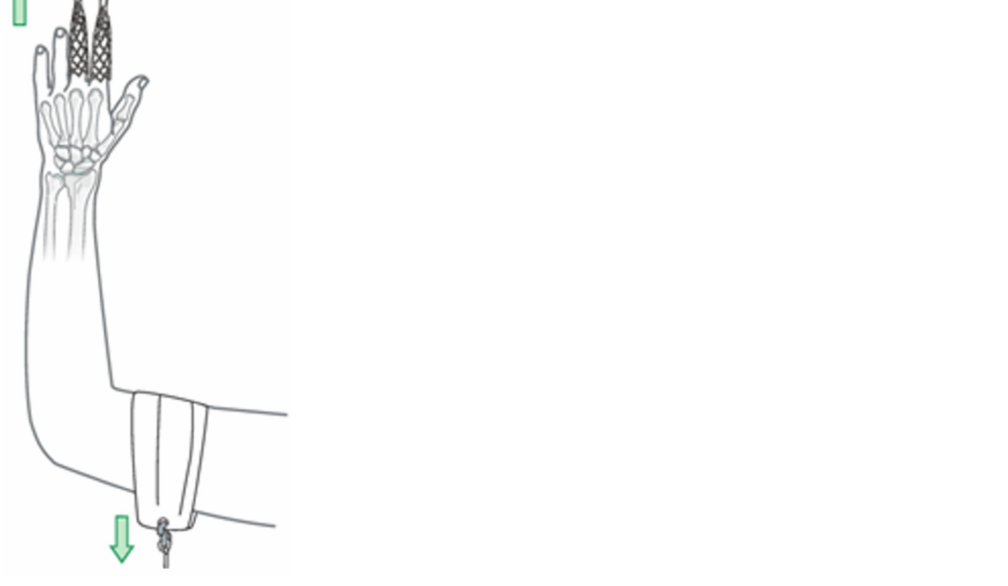
Figure 1. Illustration of a commonly used technique, the finger-trap, to induce traction in a distal radius fracture (DRF)